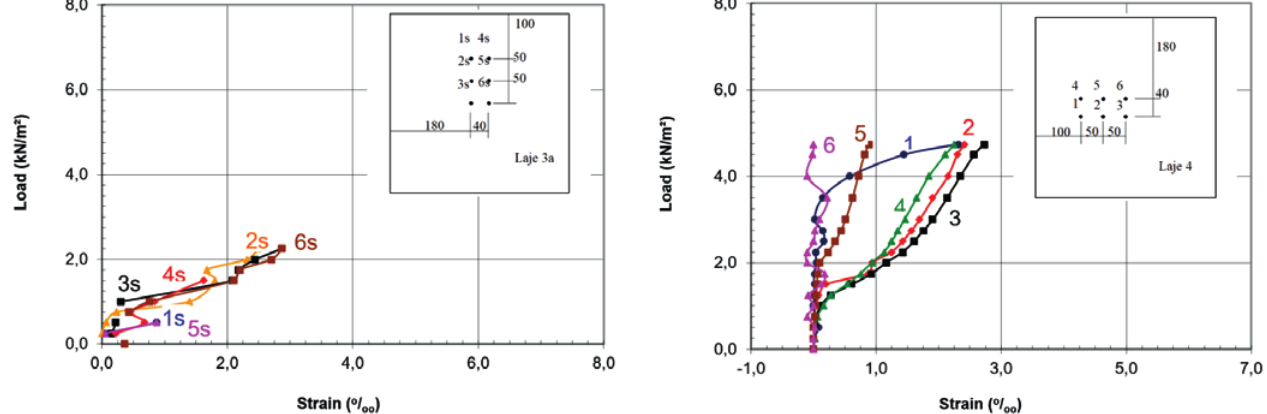
failure surface concomitantly involving part of the old-new concrete interface and the new concrete surface. Figure 11 shows a picture of the failed specimens and indicates the failure modes. Results of reference pieces showed 5% variation in the reinforced pieces and 2% variation in the non-reinforced ones. However, the adhesion strength values showed differences of almost three times between the tested slabs. Table 9 shows the mean pull-off force values and the respective standard deviations (S ) of the tests, d the failure mechanism in each of the three reinforced slabs - L2R, L3aR and L4R -, as well as the results of the reference pieces. The general calculation of the means did not take into consideration the three points in the wafer glue where the failures occurred during the tests conducted in slab L2R. All reference specimens without reinforcing layer in slabs L3aR and L4R failed in the old concrete at mean values 1.13 MPa and 1.15 MPa, respectively. The mean adhesion strength in the other two reference pieces (with reinforc- ing layer) were 1.02 MPa and 1.07 MPa, respectively; there was predominant failure in the new-old concrete interface. The pull-off stress ranged from 0.49 MPa to 1.08 MPa in the tests conducted in slab L2R, from 0.36 MPa to 1.07 MPa in the tests conducted in slab L3aR, and from 0.43 MPa at 1.03 MPa in the tests conducted